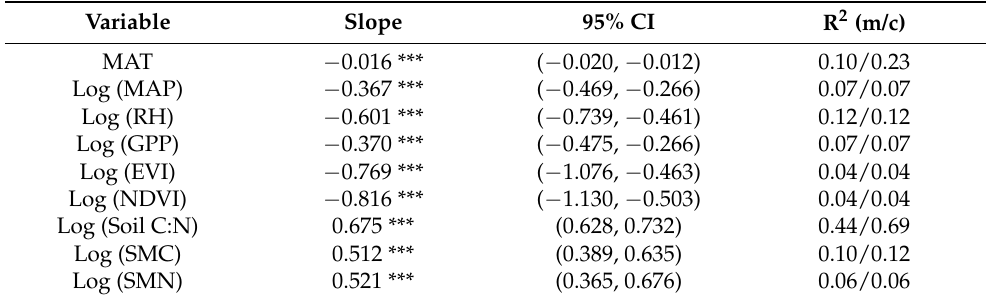
Table A3. Statistics of GLMM relating environmental variables with subsoil τ , treating the stand types by sites as a random effect. Variable